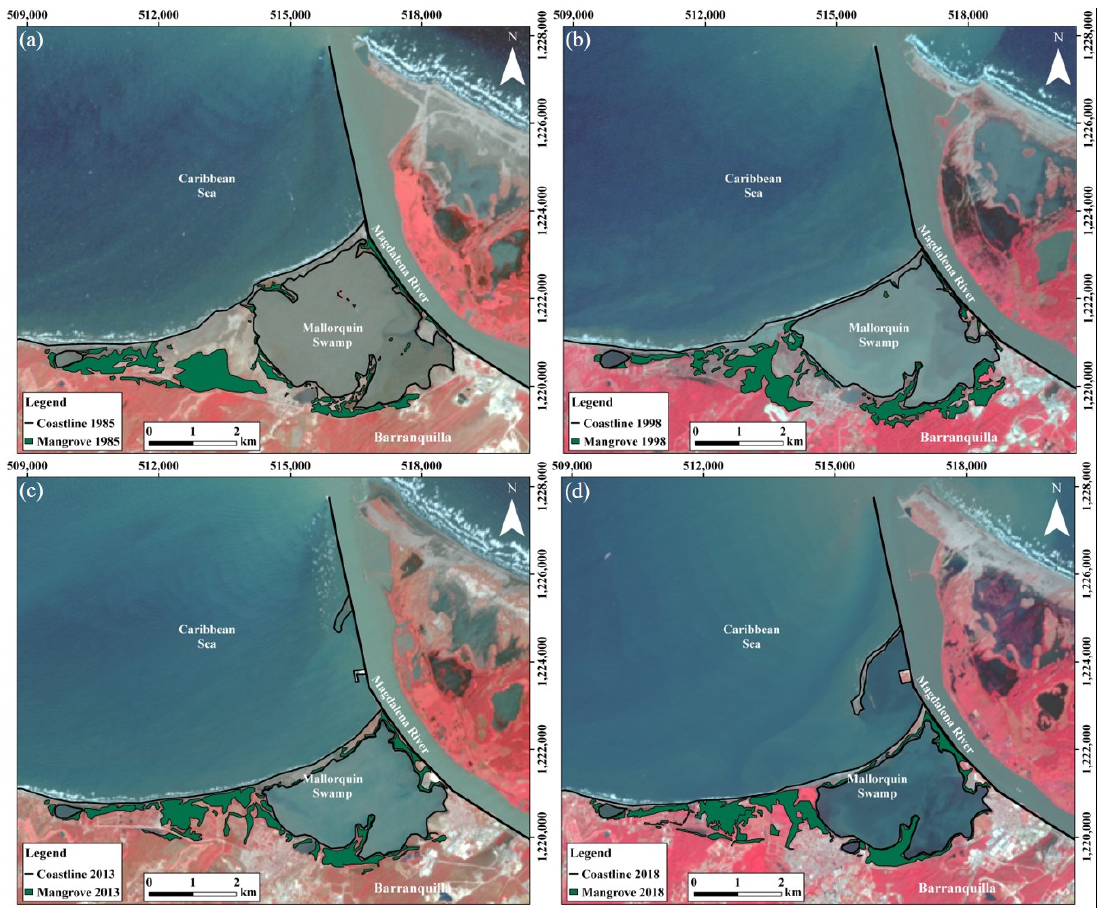
Figure 3. Evolution of the mangrove forest (green) in the Mallorquín swamp ( a ) 1985, ( b ) 1998, ( c ) 2013, and ( d ) 2018. Table 2. Variation of the mangrove forest cover (ha) in the Mallorquín, Totumo, and La Virgen swamps.